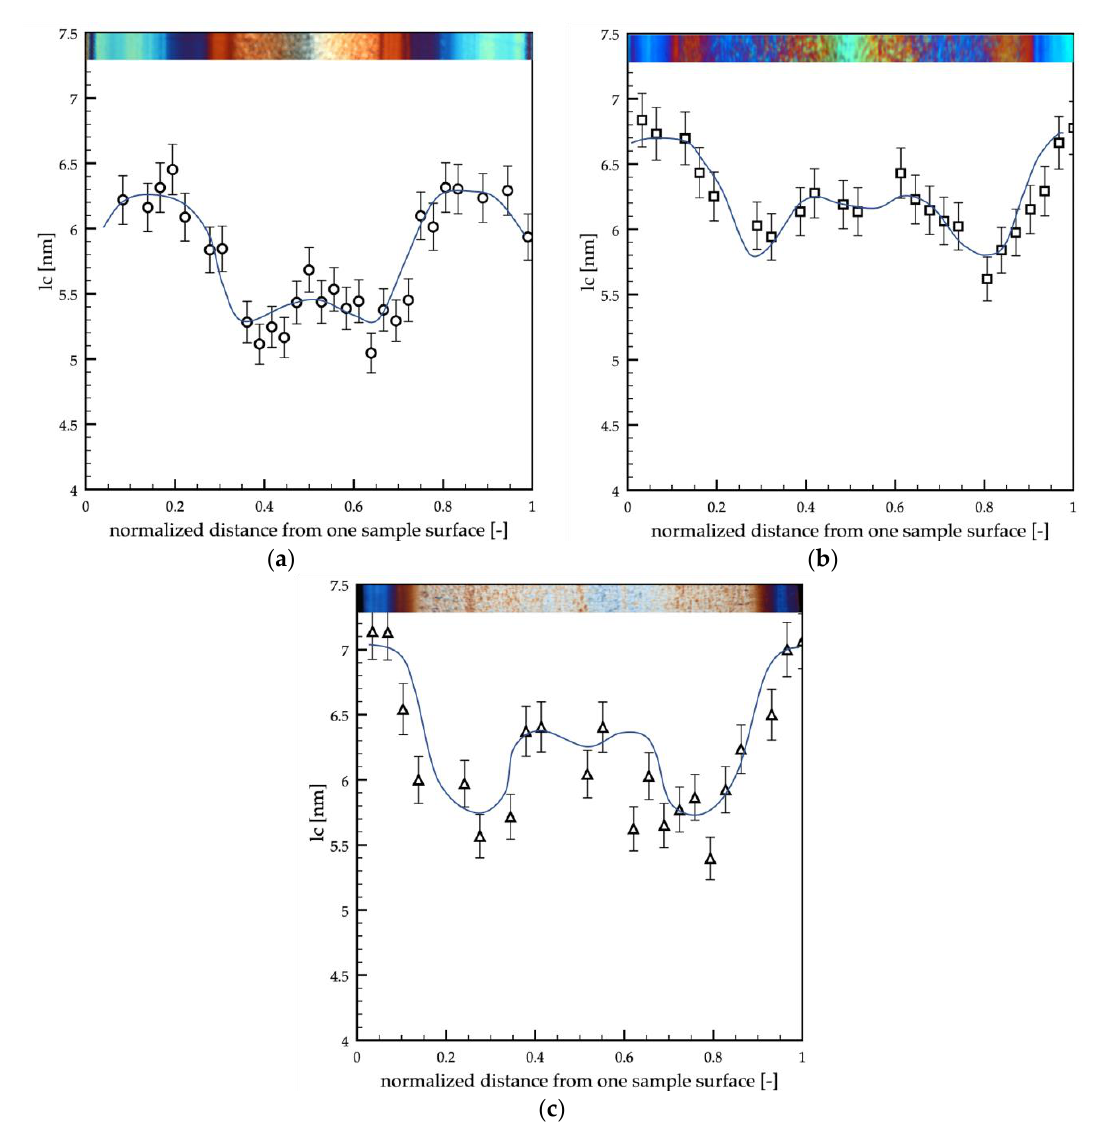
Figure 11. Lamellar size distributions along the thickness of the passive ( a ), A ( b ), and B ( c ) samples.